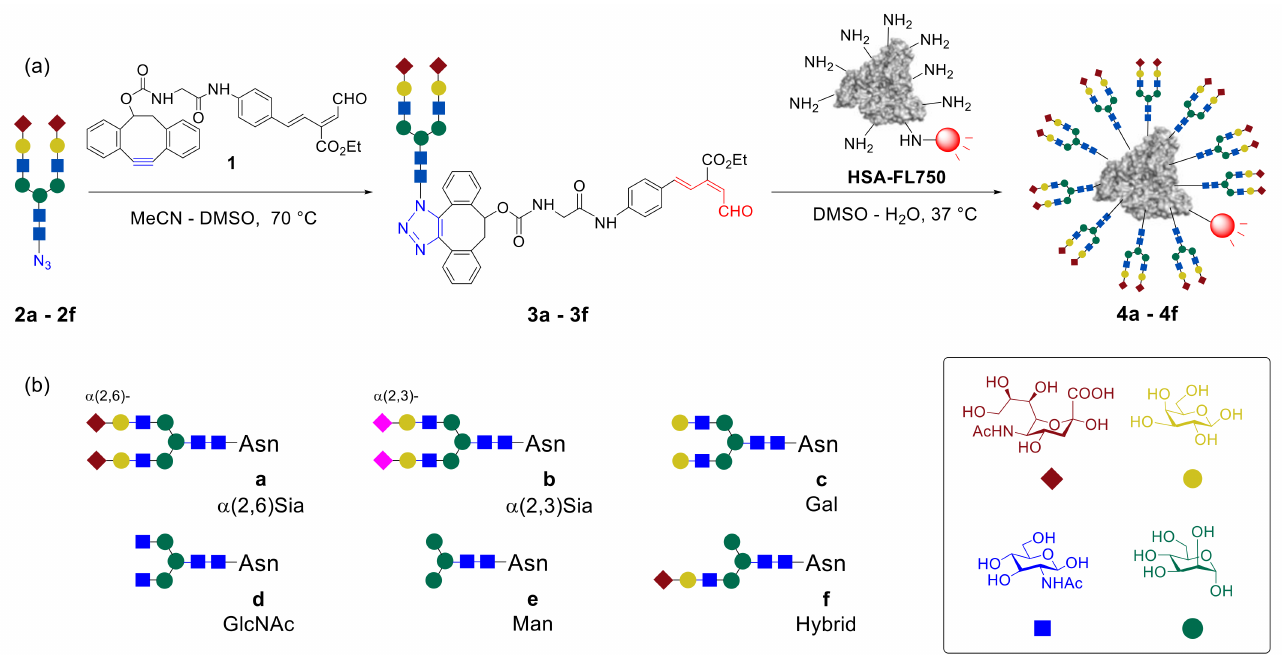
Figure 3. ( a ) Synthesis of homogeneous N -glycoalbumins 4a – f using one-pot, double-click strategy; ( b ) structures of biantennary glycans a – f